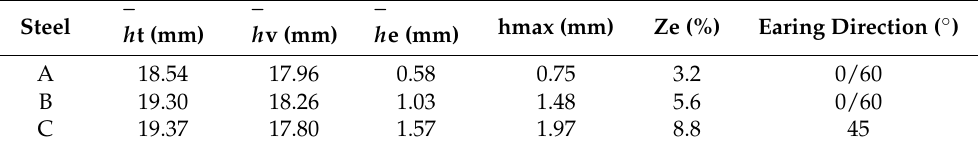
Table 3. Several important indexes to characterize the earing propensity.